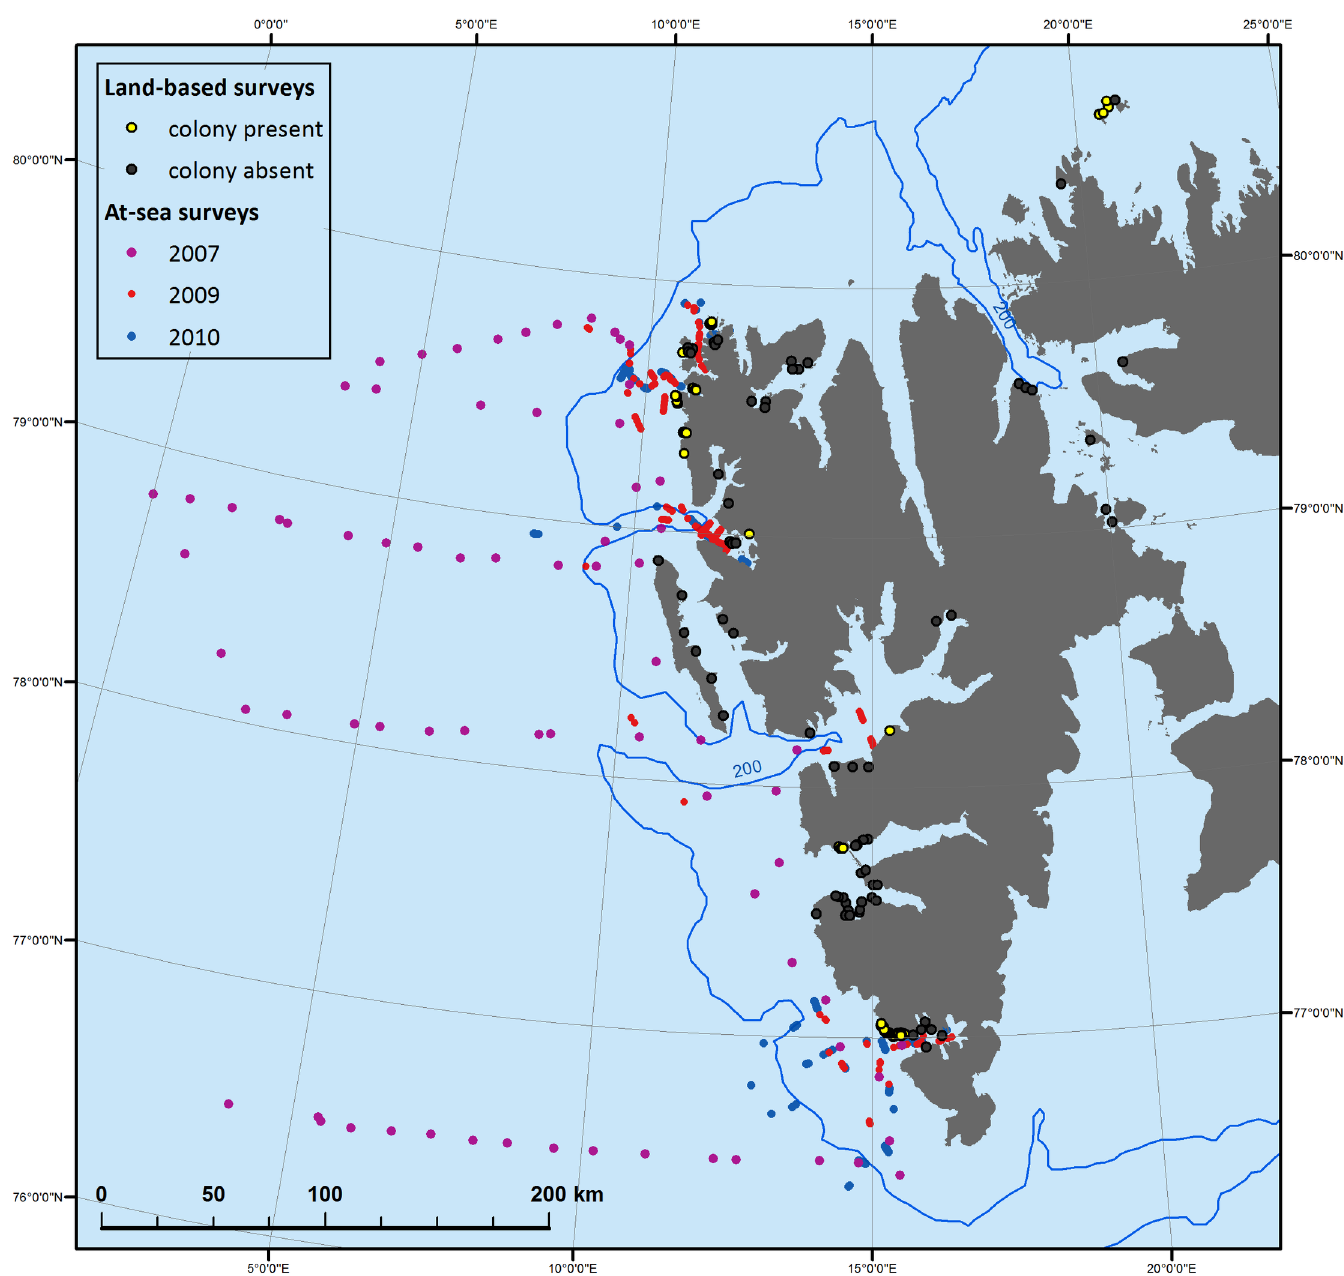
Fig 2. Study area with location of visited sites with (yellow dots) and without little auk colonies (black dots). Dots at sea indicate ship cruises during at-sea surveys of foraging birds. Background (bathymetry and contour map): NOAA Satellite Maps.